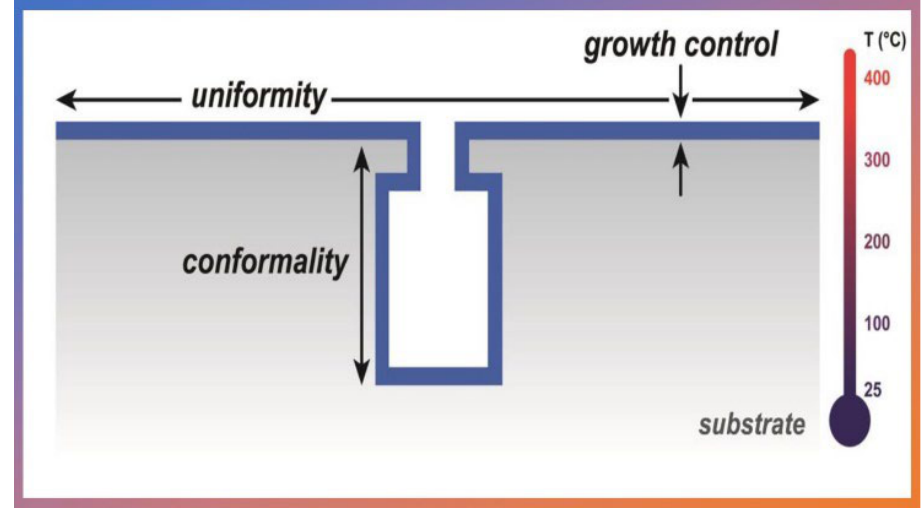
Figure 3. Schematic representation of ALD coverage metrics on 3D substrates. Reprinted with permission from Ref. [47]. Copyright 2014, Elsevier.